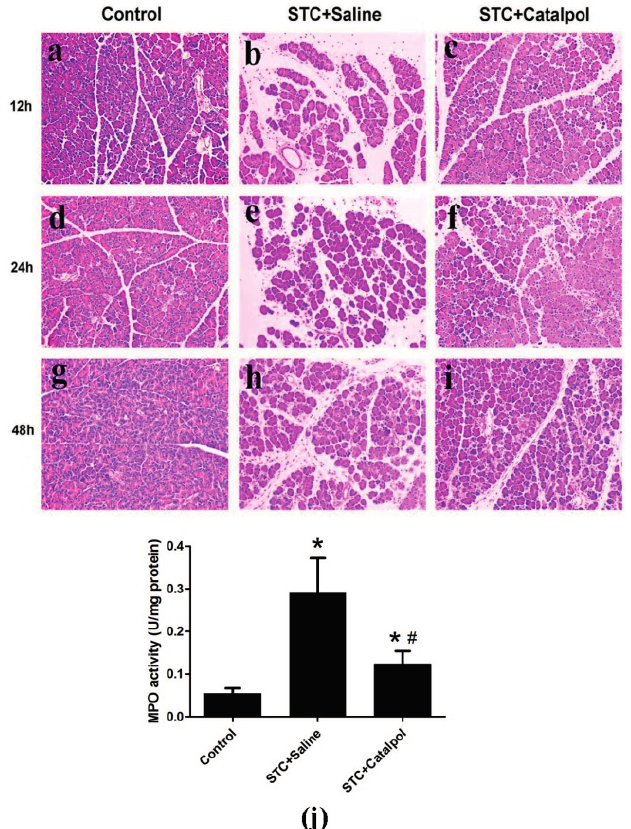
Figure 3. Representative hematoxylin and eosin (H&E)-stained sections of pancreas are shown. Control group at each time-point: ( a , d , g ); STC + saline-treated group at each time-point: ( b , e , h ); STC + catapol-treated group at each time-point: ( c , f , i) ; Original magnification: ×200, all specimens were scored by three pathologists who were unaware of their origin. MPO activity was measured 24 h after STC injection ( j ). Data are presented as means ± SD of three independent experiments. * p < 0.05, compared with the control group; # p < 0.05, compared with the STC + saline-treated group.